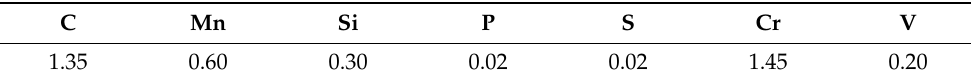
Table 1. Chemical composition of steel used (wt.%).